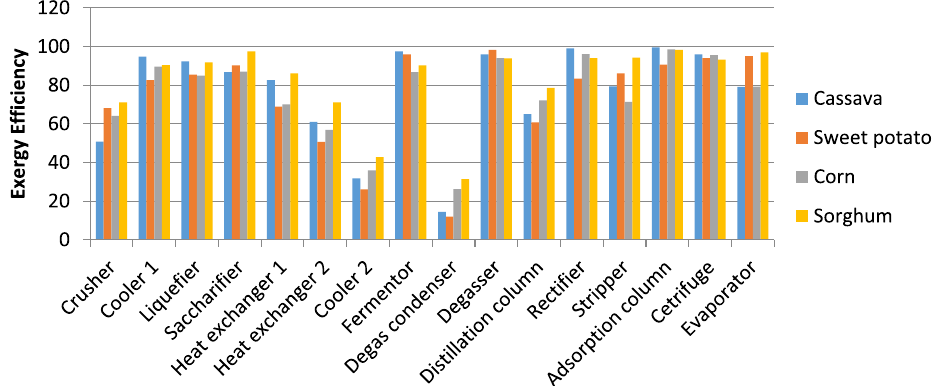
Figure 10. Exergy efficiency for starchy feedstocks conversion process.